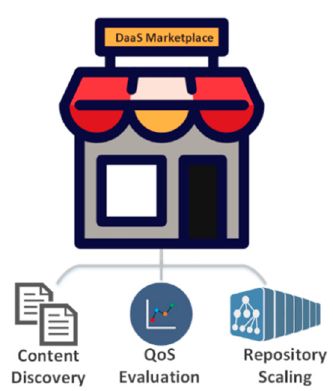
Figure 1. DaaS Marketplace general